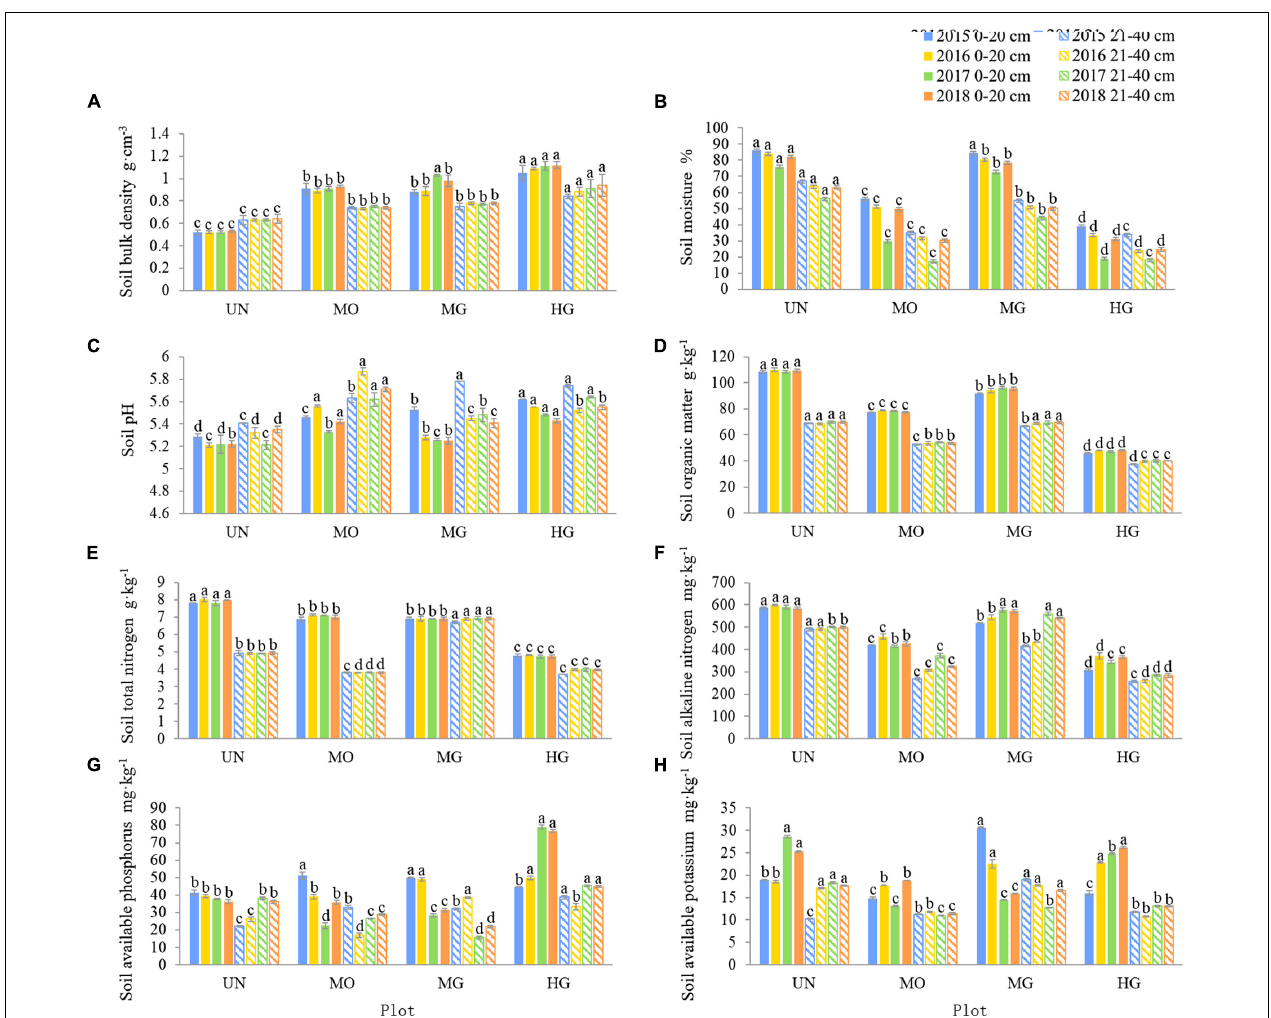
FIGURE 3 | Interannual variation in soil physicochemical properties under different utilization patterns. Different letters indicate significant differences in a physicochemical property of the same soil layer among sites within a year at the 0.05